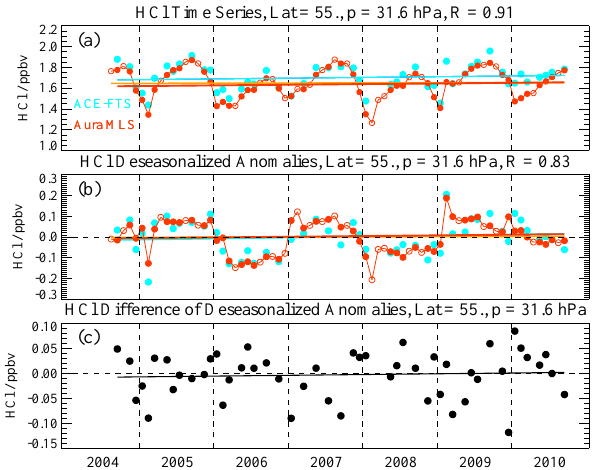
Figure 3. Example of HCl time series analyses for 50–60 ◦ N and 32hPa. (a) HCl monthly mean source data from ACE-FTS and Aura MLS; the MLS dots are filled when there is time overlap with ACE- FTS and open if no such overlap exists. Simple linear fits are shown as colored lines for ACE-FTS and for Aura MLS (orange line for all red dots and red line for filled red dots only). Correlation coefficient values ( R values) for the two time series are provided in the title. (b) Deseasonalized anomalies for both ACE-FTS and Aura MLS, with corresponding linear fits (and R values). (c) Difference of de- seasonalized anomalies (ACE-FTS minus Aura MLS), with linear fit.